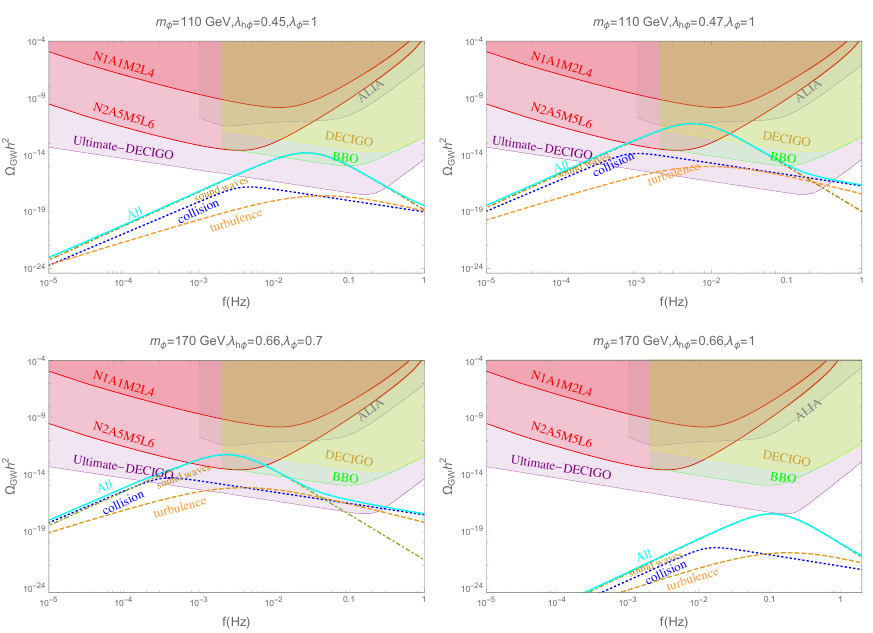
Figure 9 . The GWs generated by the SFOEWPT from three main sources: sound waves(brown dotdashed line), collision(blue dotted line), turbulence(orange dashed line) and total contribu- tion(cyan solid line). The colored regions depict the experimental sensitivities of eLISA(two con- (cid:12)gurations with notation NiAjMkLl), ALIA(gray), BBO(green), DECIGO(yellow) and Ultimate-